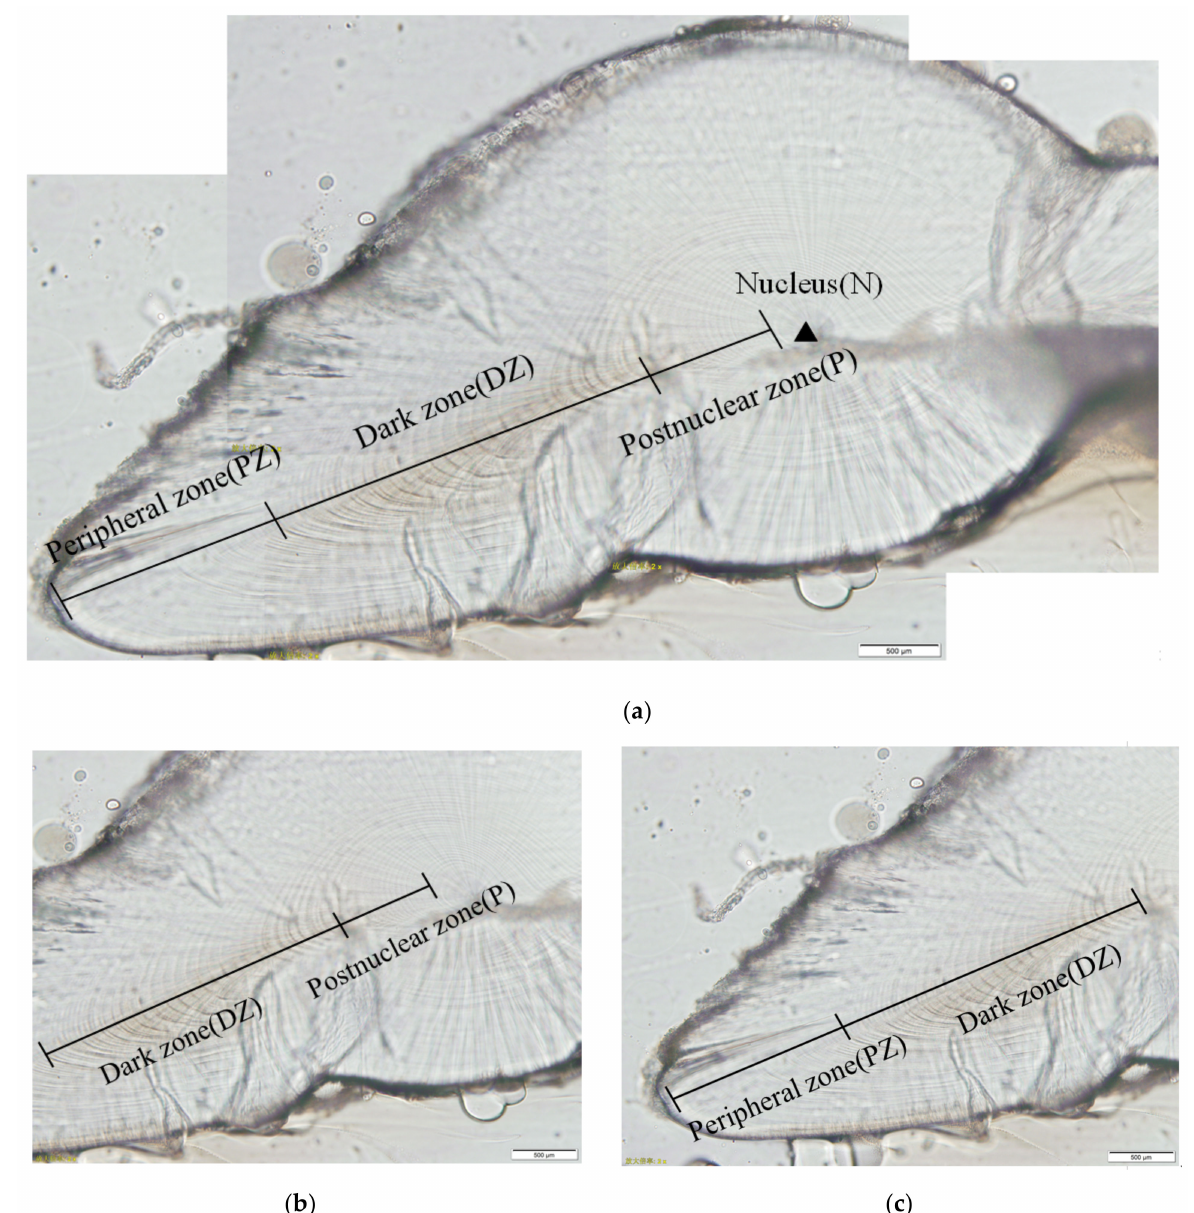
Figure 5. Statolith microstructure of S. oualaniensis : ( a ) showing three distinct growth zones with different incremental width; ( b ) showing the postnuclear zone (P) and dark zone (DZ); ( c ) showing the dark zone (DZ) and peripheral zone